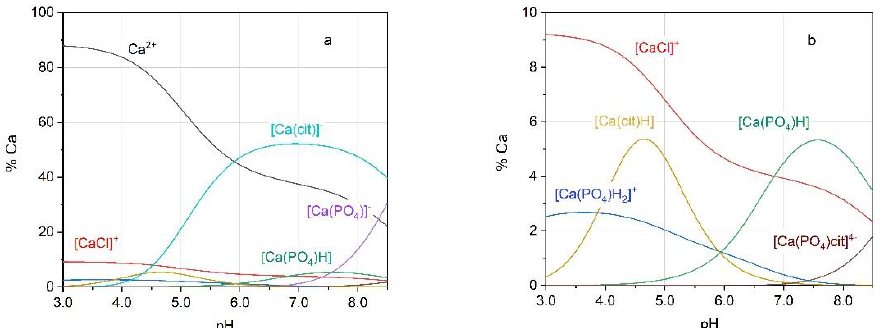
Figure 2. Speciation plots computed using the speciation model reported in Table 1. ( a ) Full figure; ( b ) zoomed figure showing the species at low formation percentage. The concentrations of the components are: Ca 2+ : 1.0 × 10 − 3 mol L − 1 ; K + : 1.0 × 10 − 1 mol L − 1 ; Cl − : 1.0 × 10 − 1 mol L − 1 ; PO 43 − : 2.5 × 10 − 3 mol L − 1 ; citrate (cit): 1.0 × 10 − 3 mol L − 1 ( I = 0.1 mol L − 1 ; t = 37 ◦